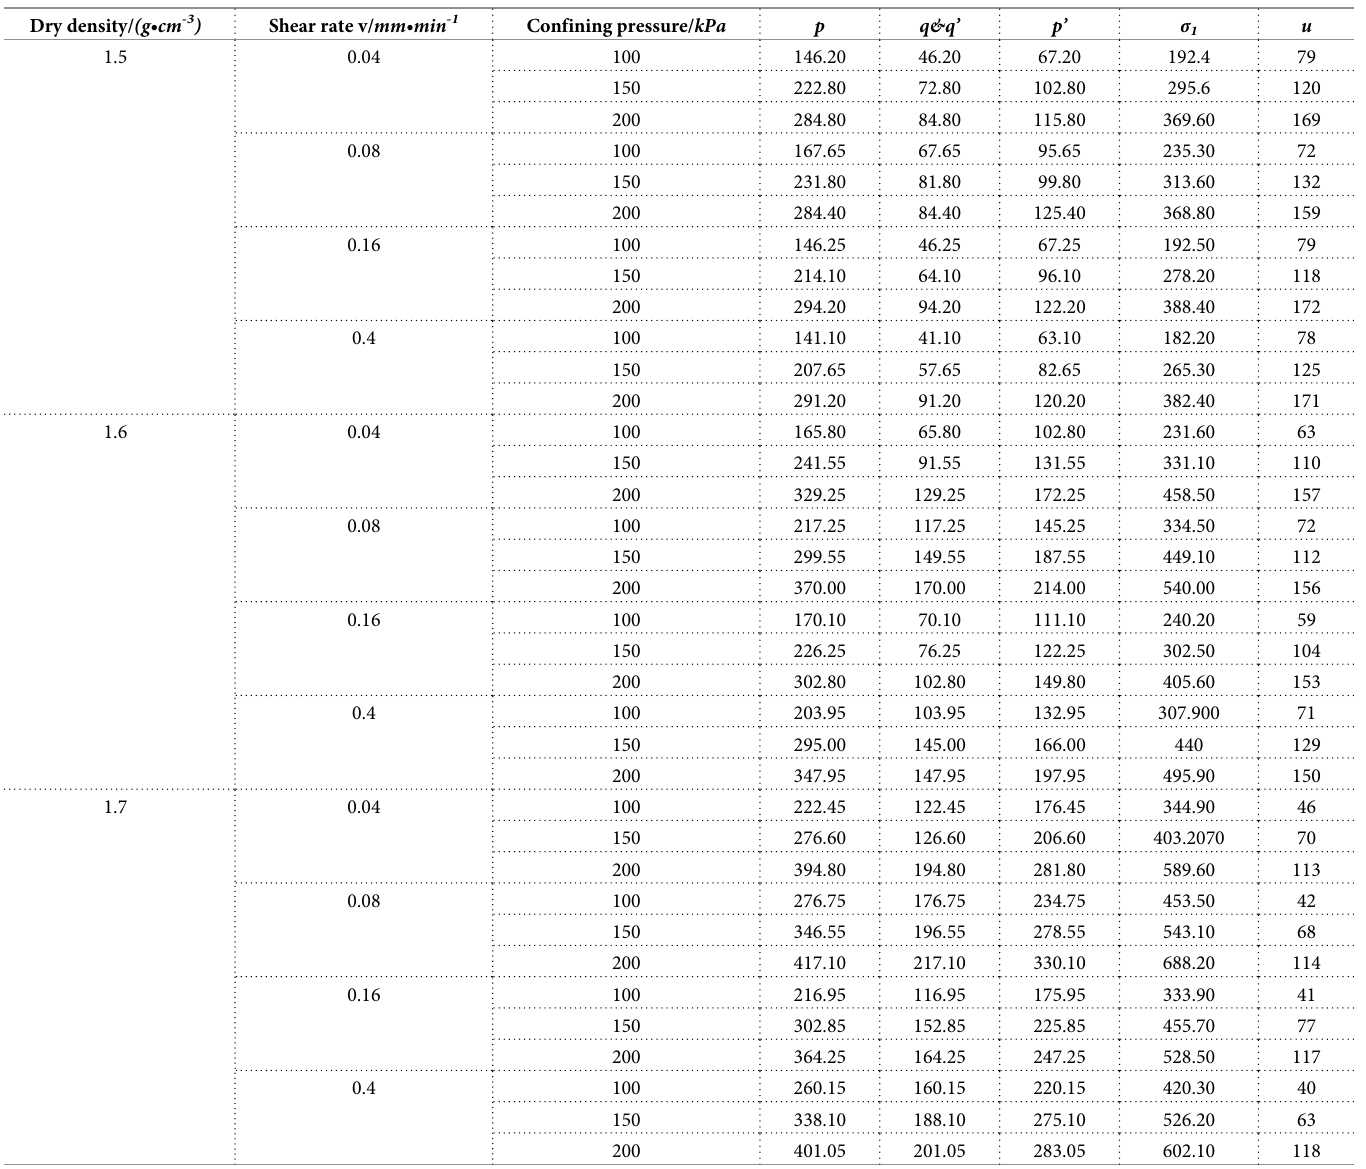
Table 3. p&p’ and q values at different dry densities and shear